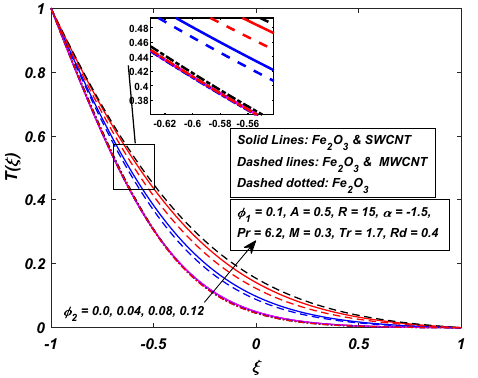
Figure 13. Influence of φ 2 on T ( ξ ).